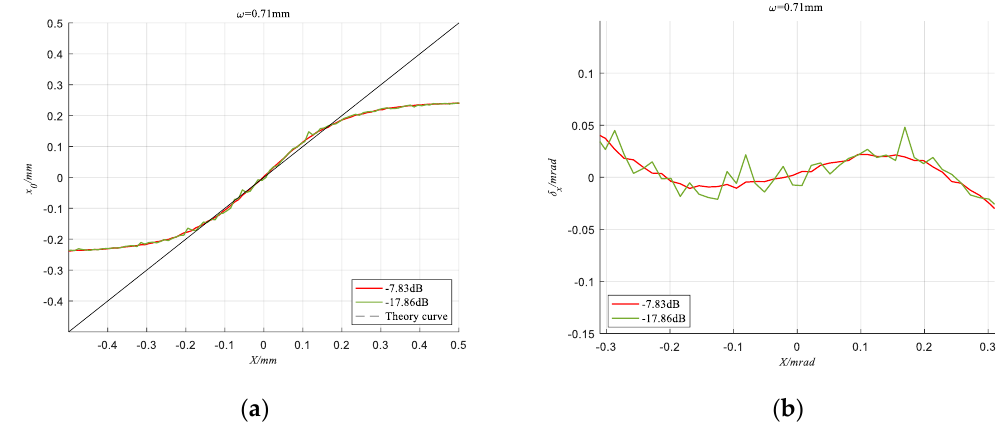
Figure 10. When ω = 0.71 mm, detection results of TRC method under different SNR conditions. ( a ) The Calculated coordinate curve; ( b ) Absolute error.